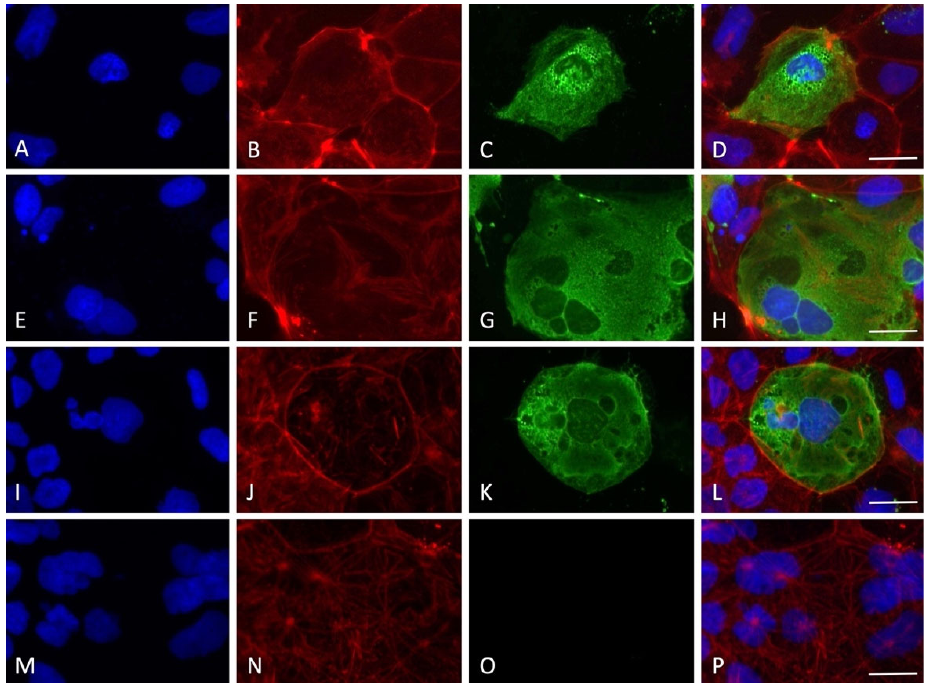
Figure 5. Immunofluorescence staining for nucleocapsid SARS ‐ CoV ‐ 2 protein with the experimental protocol employing 30 min of viral absorption (60 × magnification, scale bar 30 micron). The fluorescence for nucleus (blue), F ‐ actin cytoskeleton (red), nucleocapsid protein of SARS ‐ CoV ‐ 2 (green) and the merge of the three channels are displayed. ( A – D ) MOI 0.1; ( E – H ) MOI 0.01; ( I – L ) MOI 0.001; ( M – P ) MOI 0.0001.